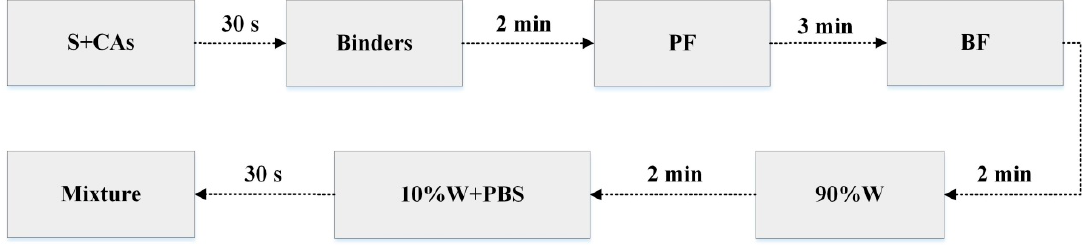
Figure 2. Schematic diagram of the mixing process of HBPRC.